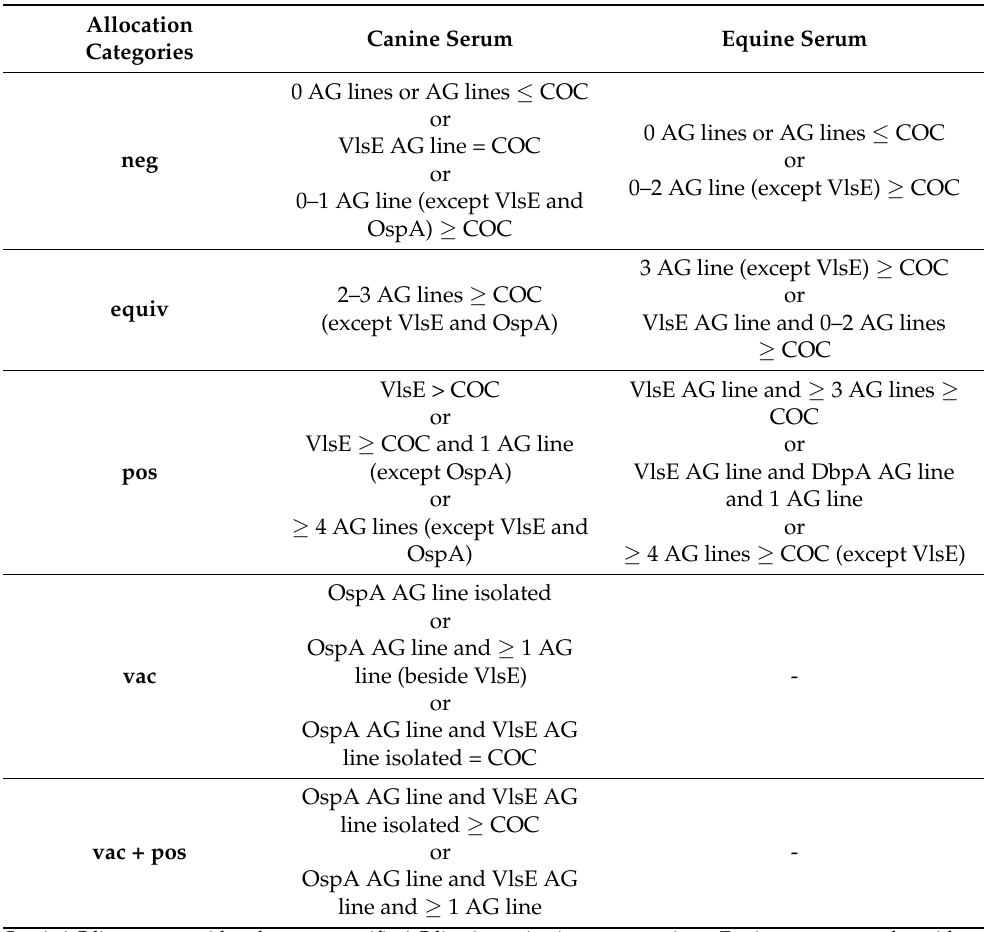
Table 4. Allocation of serum samples based on results obtained with LIA B and to its to the manufac- turer’s